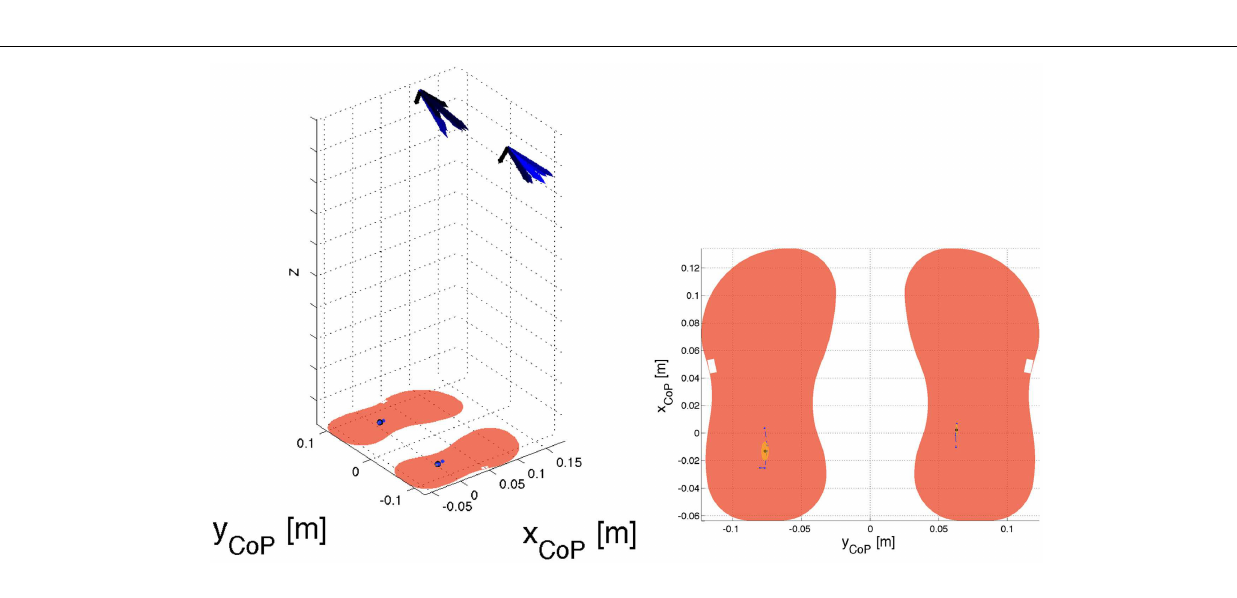
scale that goes from black (contact establishment) to blue (steady state).The right picture gives a close-up on the foot center-of-pressure positions with an ellipse that represents the Gaussian approximation of its